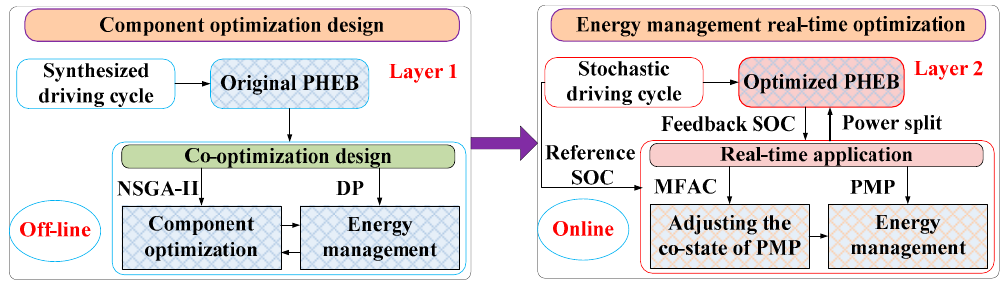
Figure 1. Process of integrated optimization.